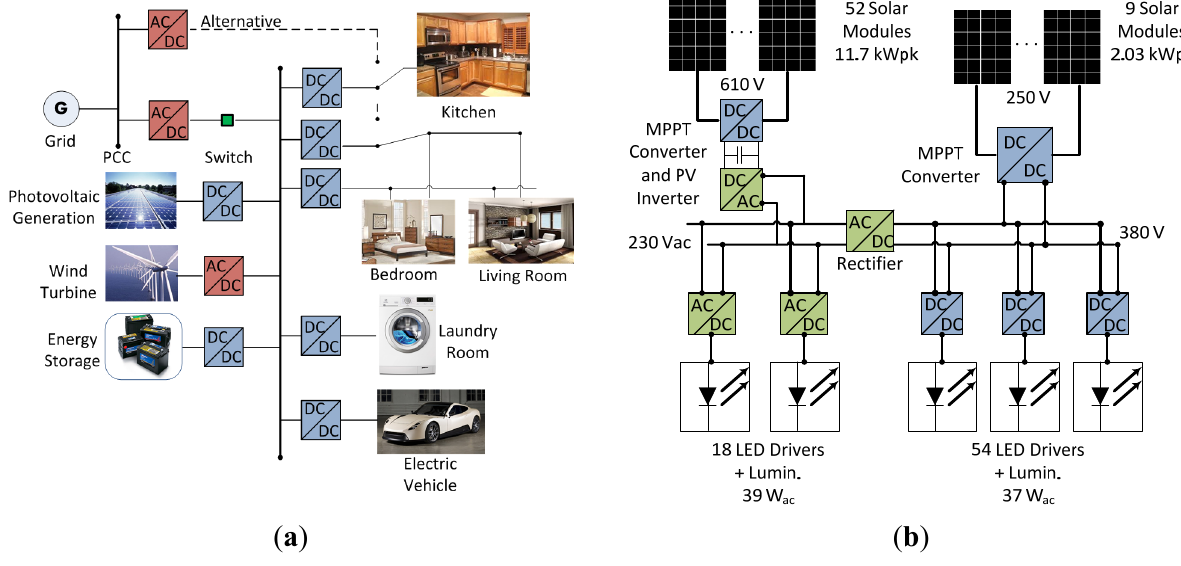
Figure 4. DC Microgrid architecture for ( a ) residential home [23] ( b ) home lighting system